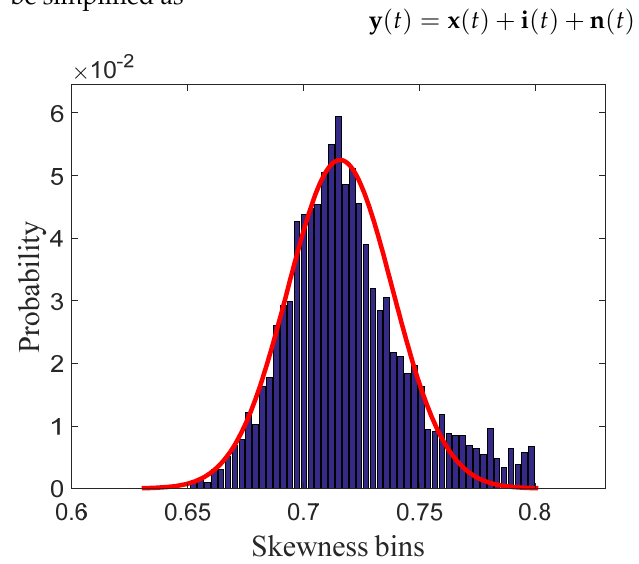
Figure 4. The skewness histogram of the RFI-free SAR dataset.